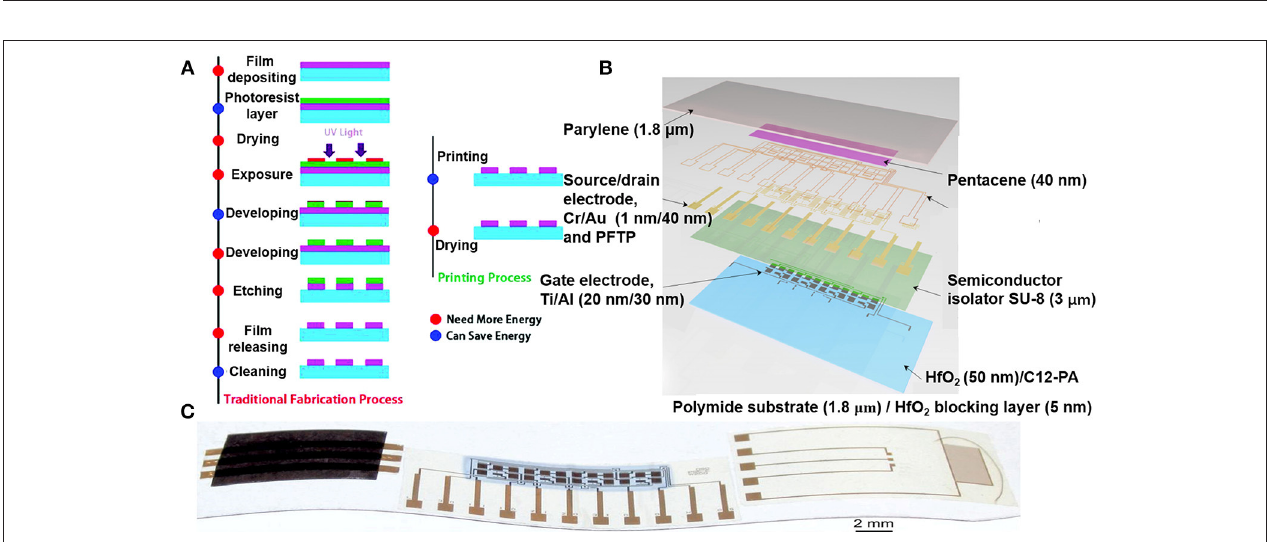
FIGURE 2 | The technologies for electrode fabrication, including two categories based on the manufacture process: top-down and bottom-up. Top-down technologies involving the physical evaporation deposition (Sahu et al., 2018), dip-pen nanolithography, (Wixforth et al., 2009), screen printing technology (Li W. et al., 2017 ), roll-to-roll technology (Bariya et al., 2018), inkjet printing technology (Xu et al., 2007), and the soft lithography (Wisser et al., 2015). Reproduced with the permission of 2018 Springer Nature Limited, SPIE Europe Microtechnologies, The Royal Society of Chemistry 2017, 2018 American Chemical Society, SPIE Europe Microtechnologies, The Royal Society of Chemistry